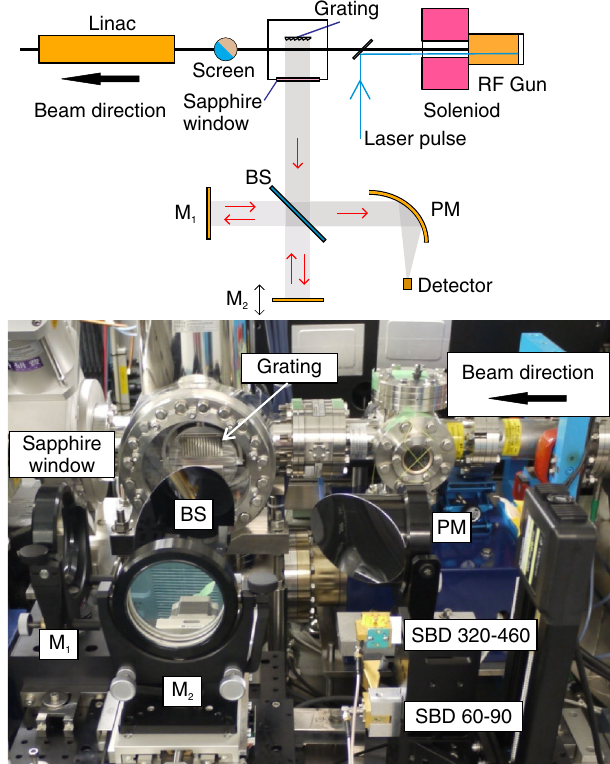
FIG. 1. Top: experimental schematics. Bottom: photograph of the experimental station. Abbreviations: M 1 — fixed interferometer mirror, M 2 — movable interferometer mirror, BS — splitter, PM — off-axis parabolic